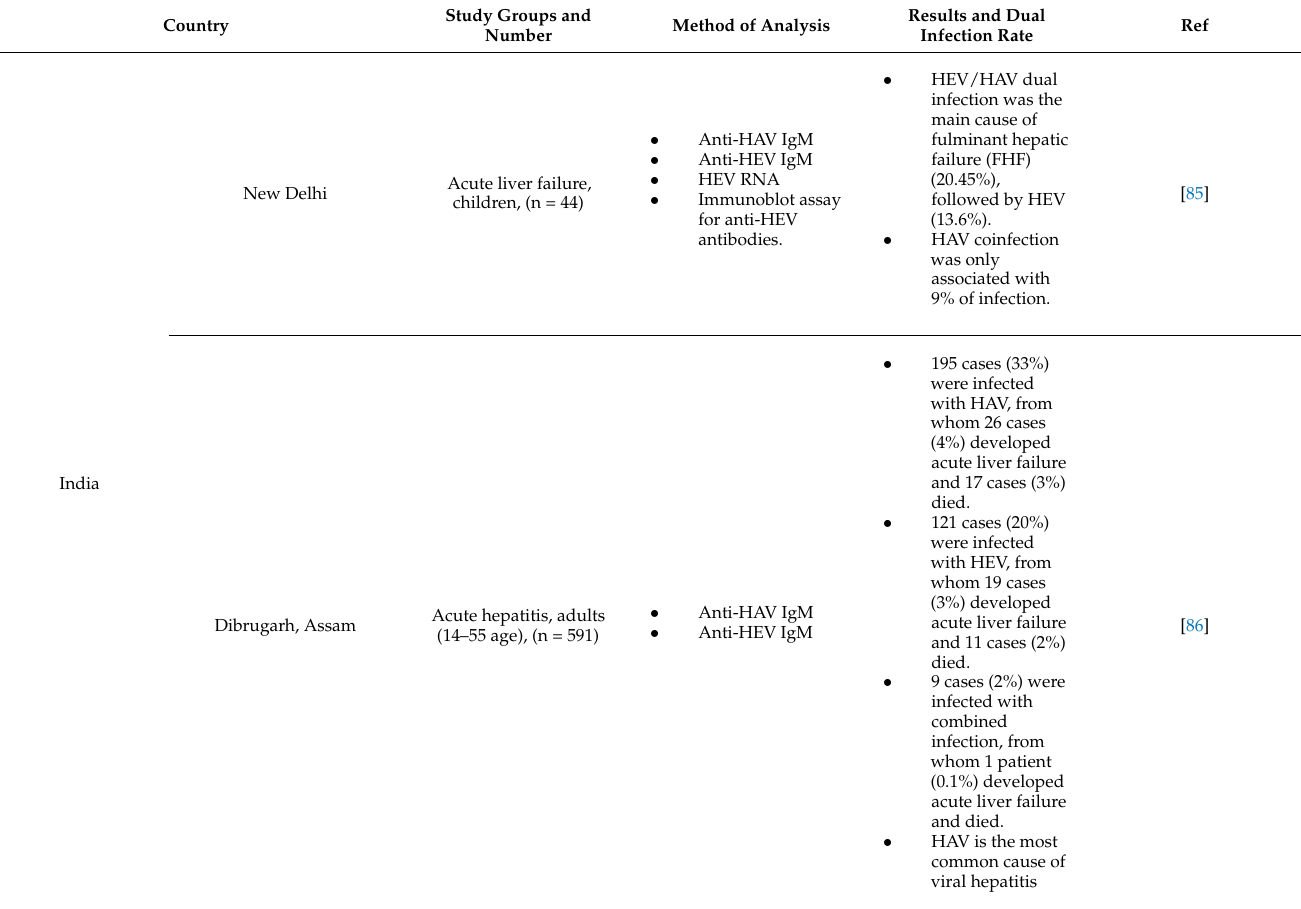
Table 1. The rate of HAV/HEV dual infection among different groups in different